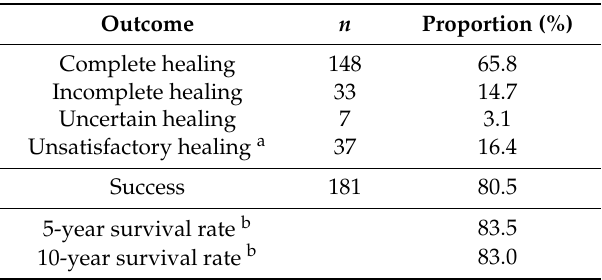
Table 1. Healing outcomes, success, and survival